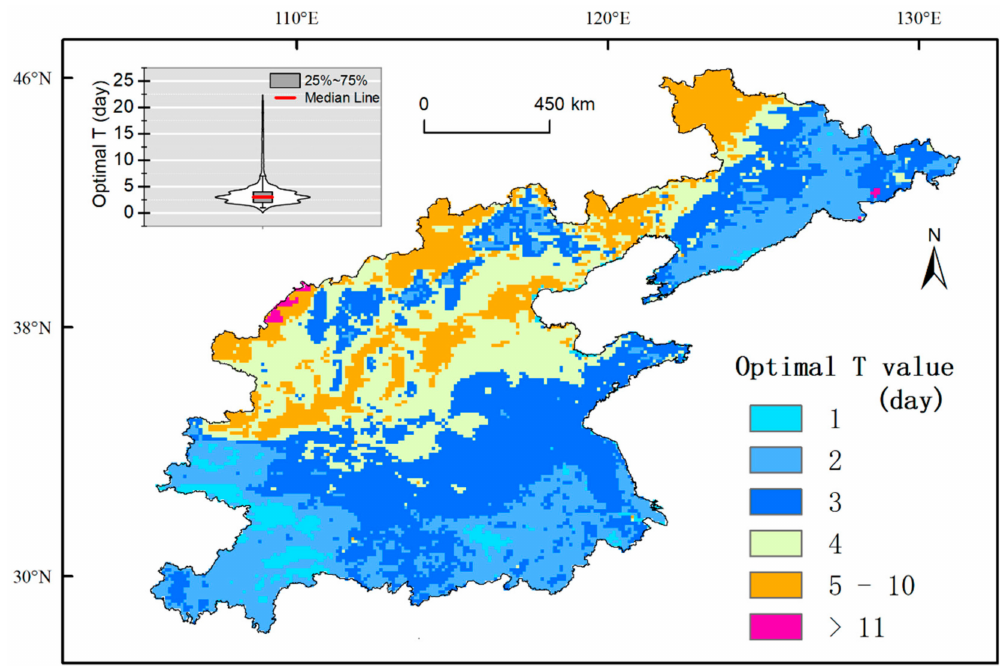
Figure 3. Distributions of optimum parameter T calibrated at 10 km grid. (Note that in the upper left violin diagrams are the distributions of the optimum parameter T for all